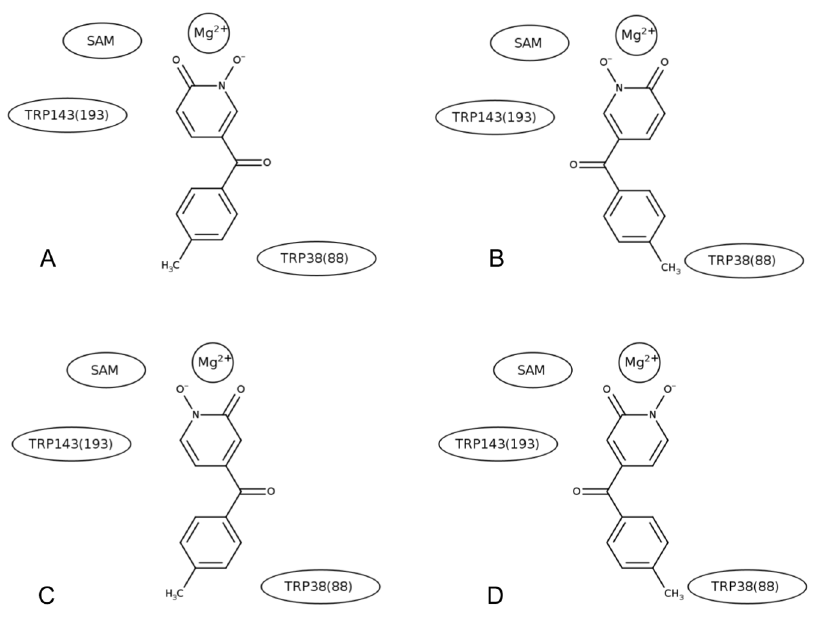
Figure 6. Different orientations of the compounds 1a ( A , B ) and 1b ( C , D ) used in the simulations.